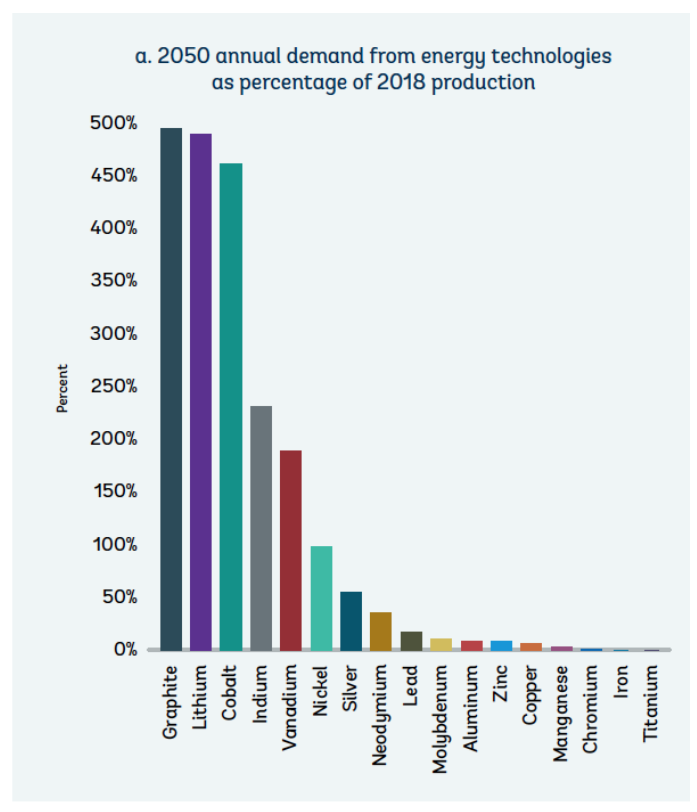
Figure 5. Predicted increase in worldwide demand for lithium and other battery materials due to growth of the EV and battery storage markets [20]. It is estimated that lithium demand in 2050 will be over 2 million tons LCE [20]. Creative Commons Attribution (CC BY 3.0